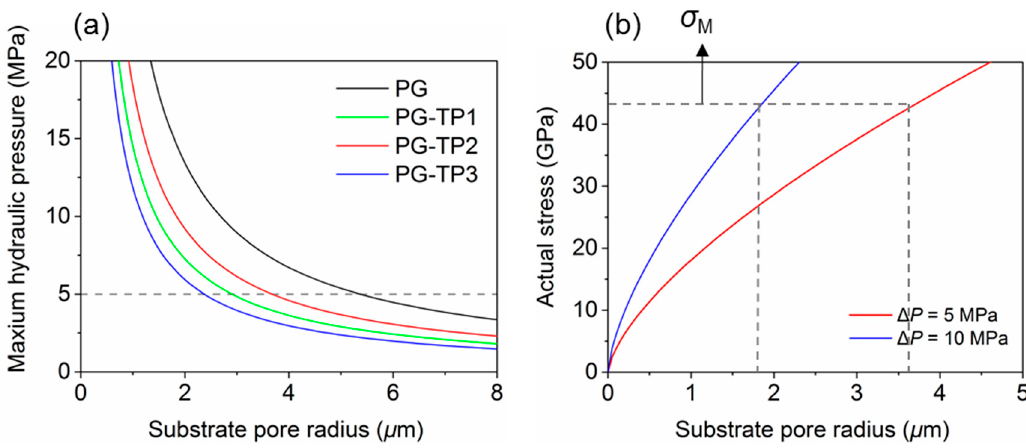
Figure 5. ( a ) Maximum hydraulic pressure as a function of substrate pore radius. ( b ) Stress in membrane as a function of substrate pore radius under different hydraulic pressure (PG-TP2).